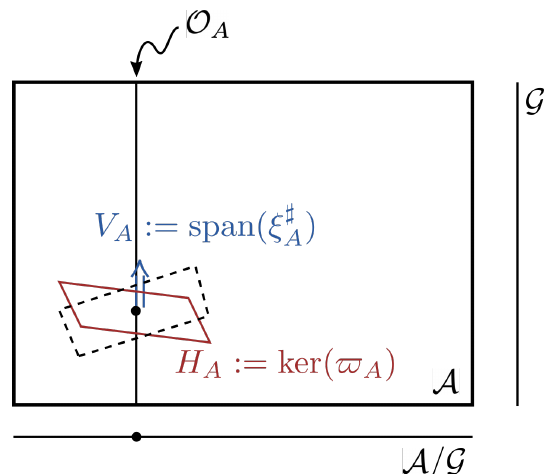
A into a vertical subspace V A A defined as the kernel A